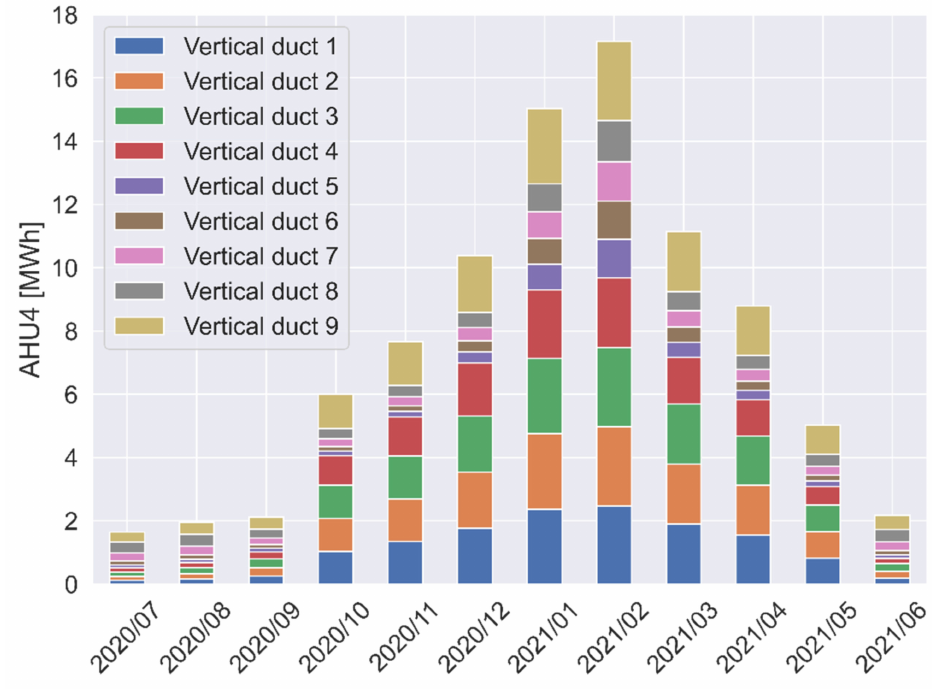
Figure 24. AHU4: monthly energy delivered by